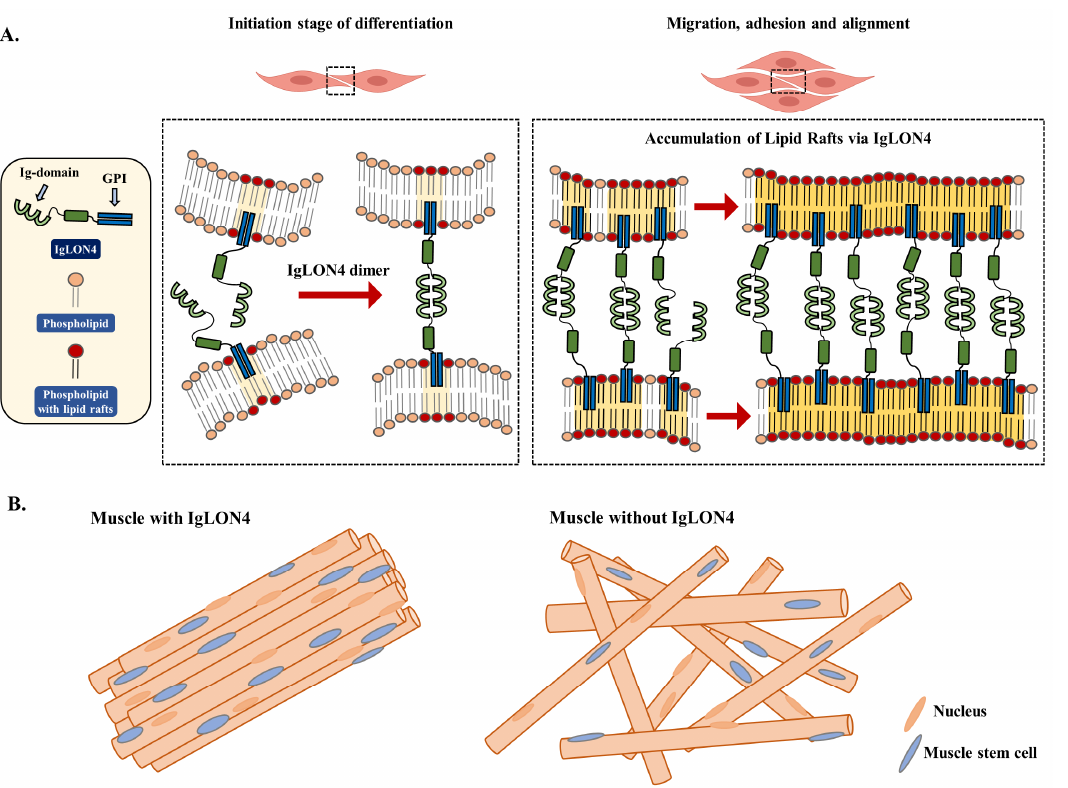
Figure 7. The proposed role of IgLON4 during myoblast differentiation. ( A ) Schematic structure of IgLON4, its membrane location, and its association with lipid raft accumulation during myoblast differentiation ( B ) Illustrations of the hypothetical structure of IgLON4-blocked muscle and normal muscle.